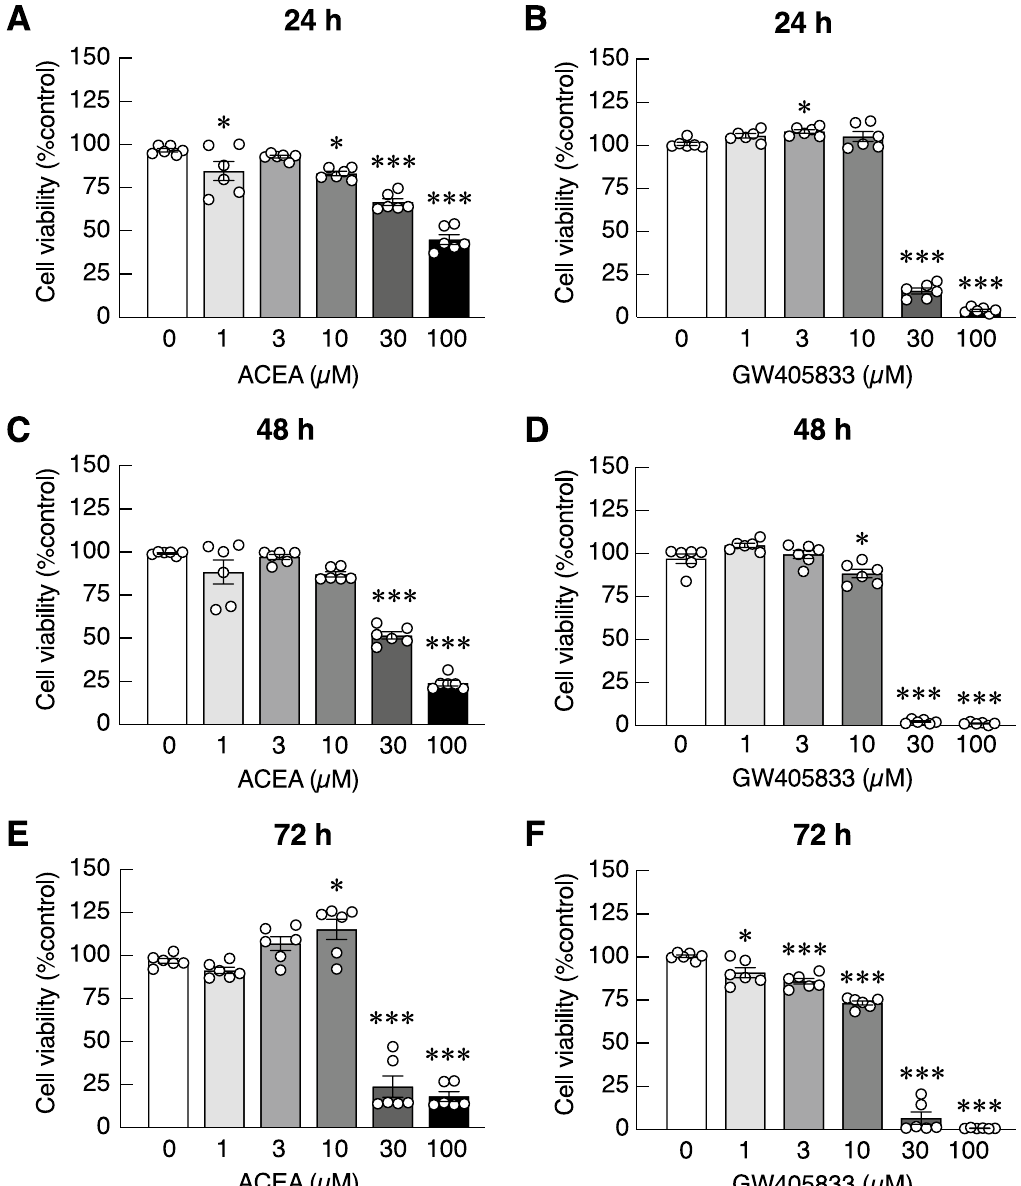
Figure 3. Cytotoxic effects of ACEA ( a , c , e ) and GW405833 ( b , d , f ) on MDA-MB-231 cell viability were measured by MTT assay. Cells were treated with the compounds of various concentrations (0–100 µM) for 24, 48 or 72 h. The results were expressed as mean ± SEM of three independent biological replicates with two technical replicates each. (*** p < 0.001, * p < 0.05).